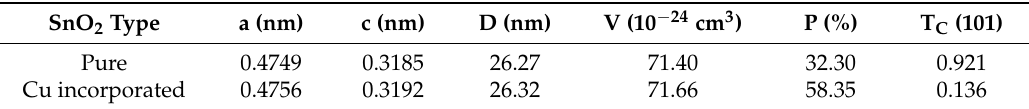
Table 1. Crystallite size (D), lattice constants (a and c), volume of the crystal (V), porosity (P), and texture coefficient (T C (101)) of the pure and Cu-incorporated SnO 2